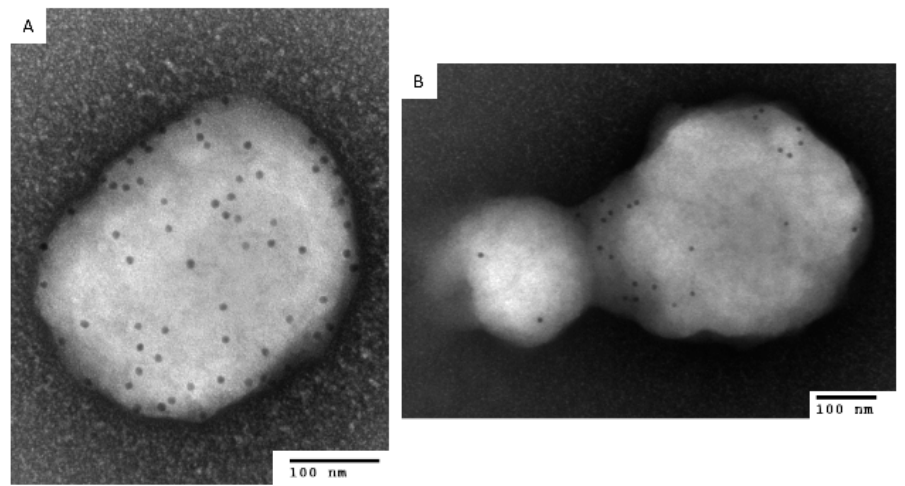
Figure 2. Immunoelectron microscopy of a fresh preparation of monkeypox virus using either an anti-EV antibody (10F10) or anti-MV antibody (5D8). To confirm the relative absence or presence of EV in our crude and/or fresh preparations of monkeypox virus, immunoelectron microscopy was utilized. ( A ) Crude preparation with anti-MV antibody; ( B ) fresh preparation with anti-EV antibody. Scale bars are 100 nM.